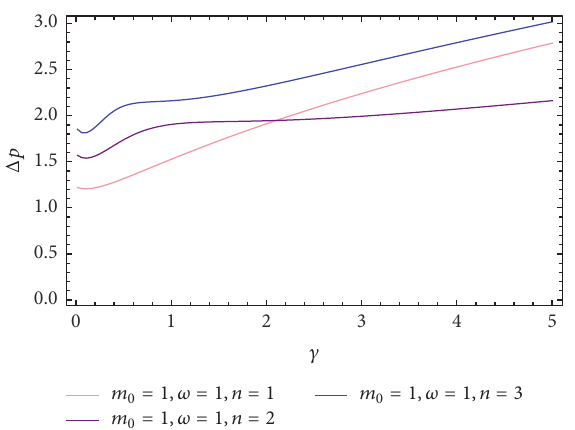
∞ Ψ 𝑛∗ (𝑥)𝑥Ψ (𝑥)𝑑𝑥 and average for 𝑥 2 is ⟨𝑥 2 ⟩ = as ⟨𝑥⟩ = ∫ 𝑛 −∞ ∫ ∞ Ψ 𝑛∗ (𝑥)𝑥 2 Ψ (𝑥)𝑑𝑥 . From (23), the average of the modi- 𝑛 −∞ fied momentum is ⟨𝑝⟩ = 0 and average for 𝑝 2 is ⟨𝑝 2 ⟩ = ∗ (𝑥)(𝑑 2 /𝑑𝑥 2 )Ψ Ψ (𝑥)𝑑𝑥 [41, 42]. We have plotted −ℎ 2 ∫ ∞ 𝑛 𝑛 −∞